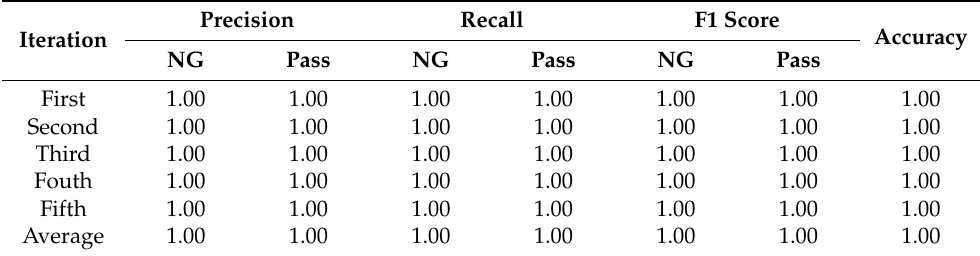
Table A3. InceptionV3 + GAP with K-fold Iterations.